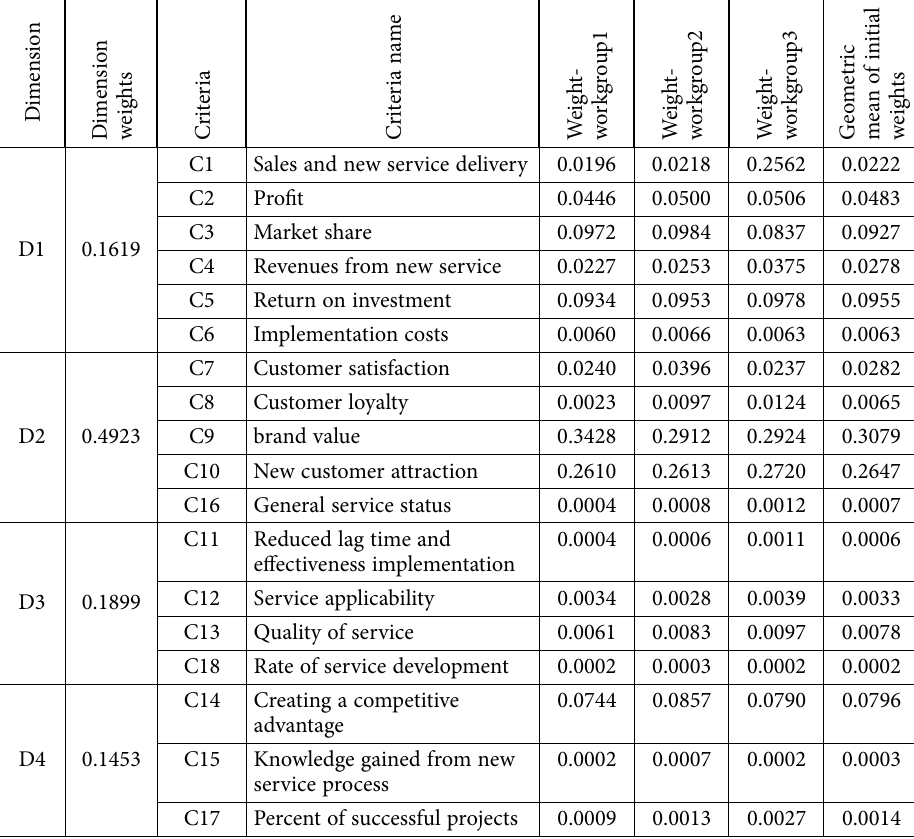
Table 7. Weighted matrix based on expert opinions